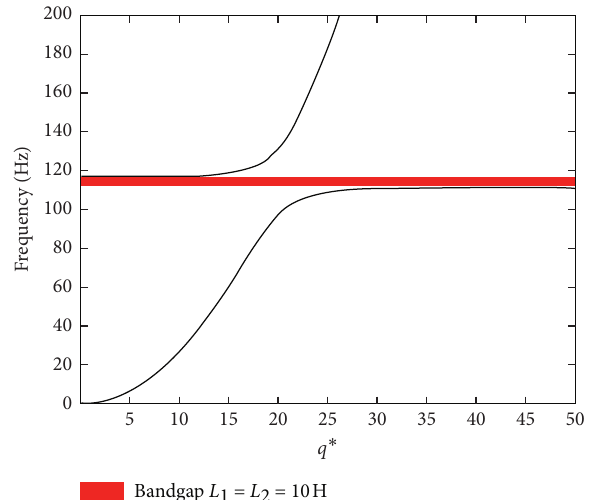
Figure 3: Band structures of the metamaterial beam in pure inductance circuit when l